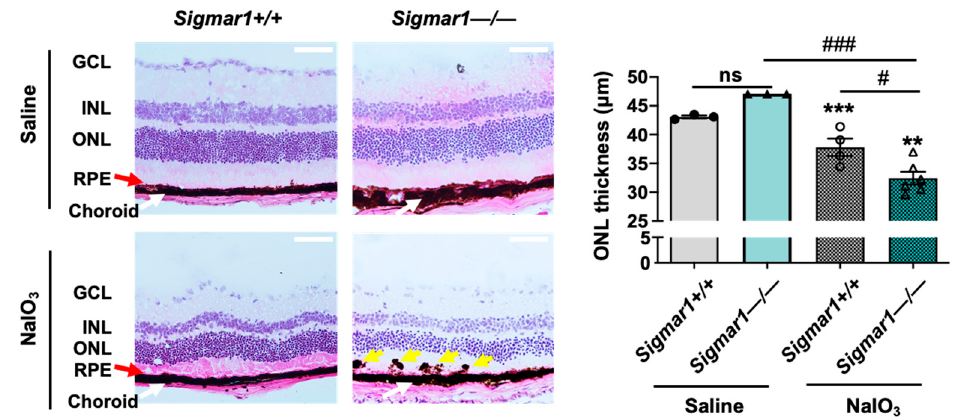
Figure 2. Comparison of photoreceptor loss in NaIO 3 -challenged Sigmar1 +/+ and Sigmar1 − / − mice. Mice received saline (PBS) or 30 mg/kg NaIO 3 through tail-vein injection. Eyeballs were collected 3 days after injection, and fixed retinal sections were H&E stained. RPE: retinal pigment epithelium. ONL/INL: outer/inner nuclear layer. GCL: ganglion cell layer. Red arrow marks the RPE layer. Yellow arrow points to pigmented blebs in the RPE layer. Scale bar: 50 μ m. Quantification: Data are presented as mean ± SEM. In the NaIO 3 -treated group, n = 4 Sigmar1 +/+ mice (8 eyes) or n = 6 Sigmar1 − / − mice (12 eyes); in the saline-treated group, n = 3 Sigmar1 +/+ mice (6 eyes) or 3 Sigmar1 − / − mice (6 eyes). Statistics: one-way ANOVA and Tukey test; # p < 0.05, ### p < 0.001; ns, not significant. ** p < 0.01, *** p < 0.001, compared to the first bar.